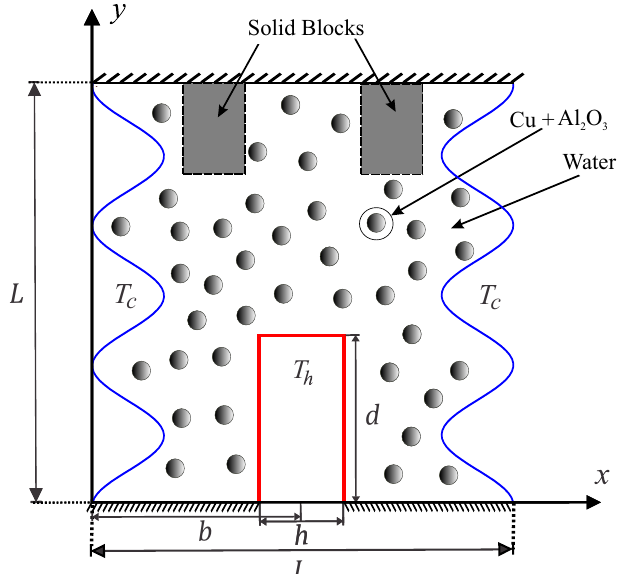
Figure 1. Schematic view of the physical model, geometrical details, and the enclosure containing the inner solid blocks and the coordinate